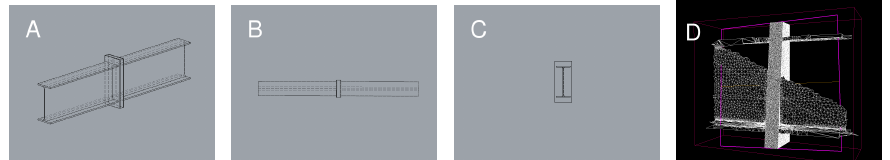
Figure 3. ( A ) The I-beam IPE400 with a thermal break in parallel perspective projection. ( B ) Top view. ( C ) Right view. ( D ) Section of the tetrahedral